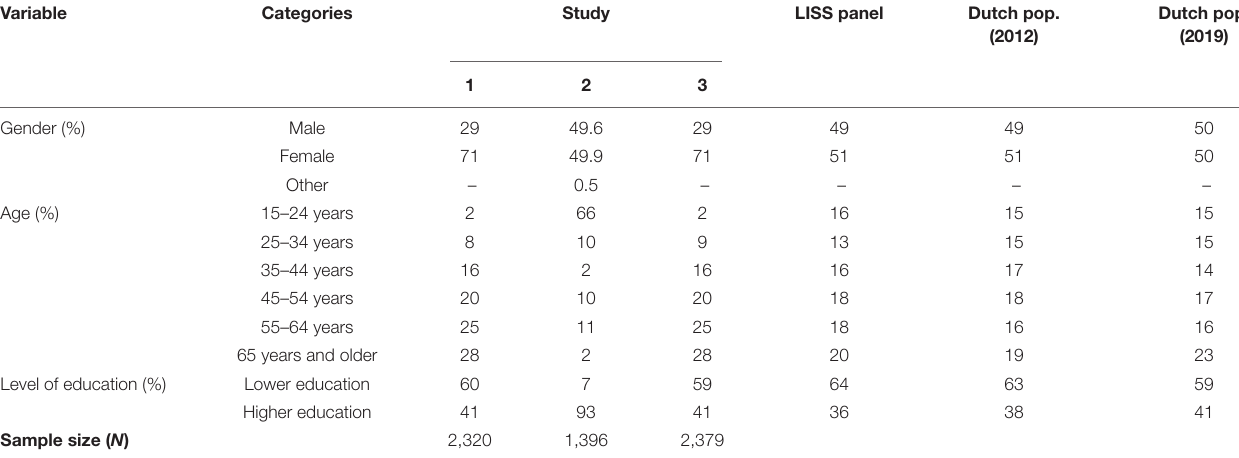
TABLE 2 | The sample distributions of social-demographic characteristics in comparison to LISS panel and population distributions.